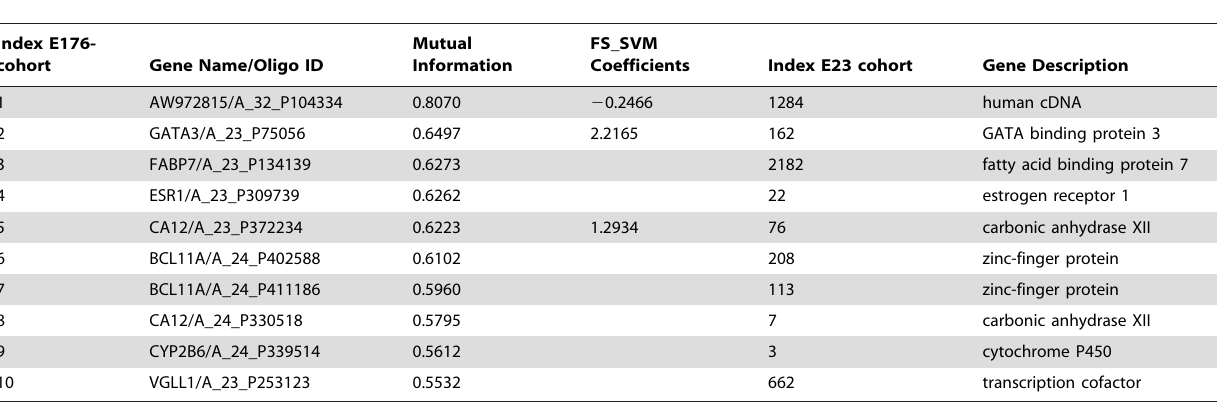
Table 1. Top 10 genes, sorted by mutual information related to ER-status, based on the E176-cohort.